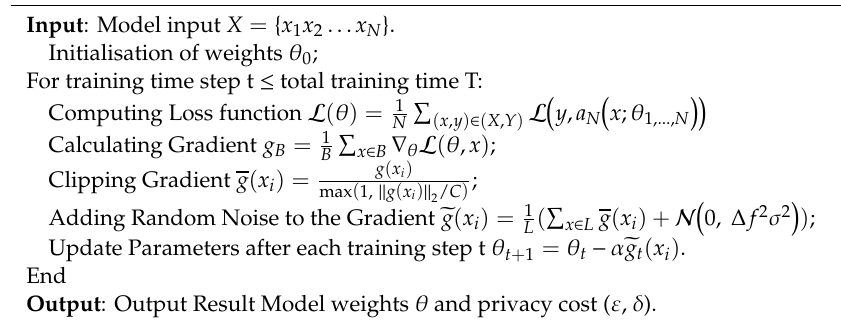
Algorithm A1. Privacy-preserving Deep Neural Network Algorithm